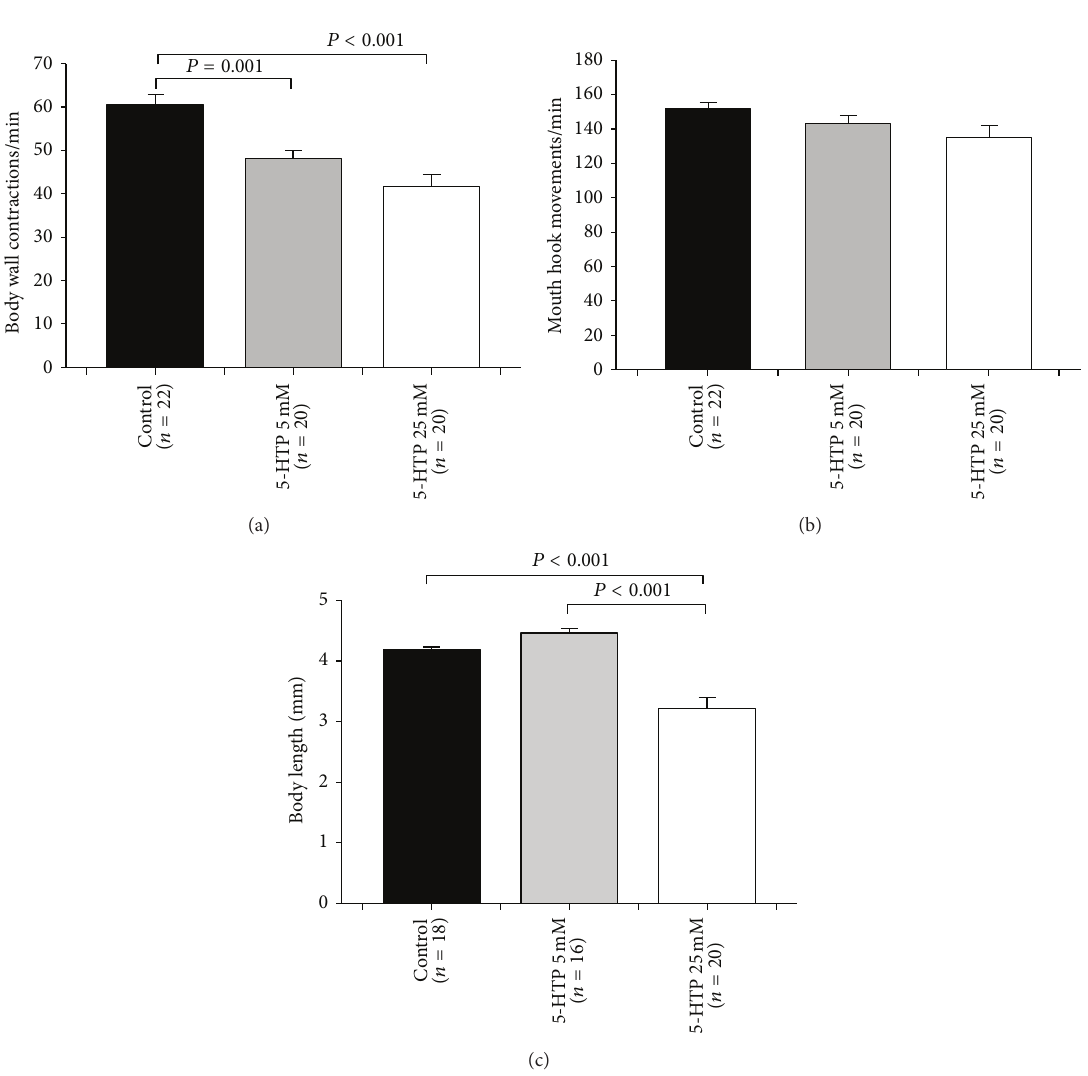
Figure2:Theeffectof5-hydroxytryptophan(5-HTP),a5-HTprecursor,onfeedingandlocomotionbehaviors.(a)5-HTP(5mMand25mM) significantly reduced the body wall contractions in larvae. (b) When the larvae were fed on food mixed with 5-HTP, no significant difference was observed in feeding behavior in comparison to control animals (CS). (c) Body length significantly decreased at 25 mM 5-HTP. One-way ANOVA was used for comparison, and Bonferroni 𝑡 -test was employed to compare treatments with control group. Data represented as mean ± SEM. 𝑃 value < 0.05 is